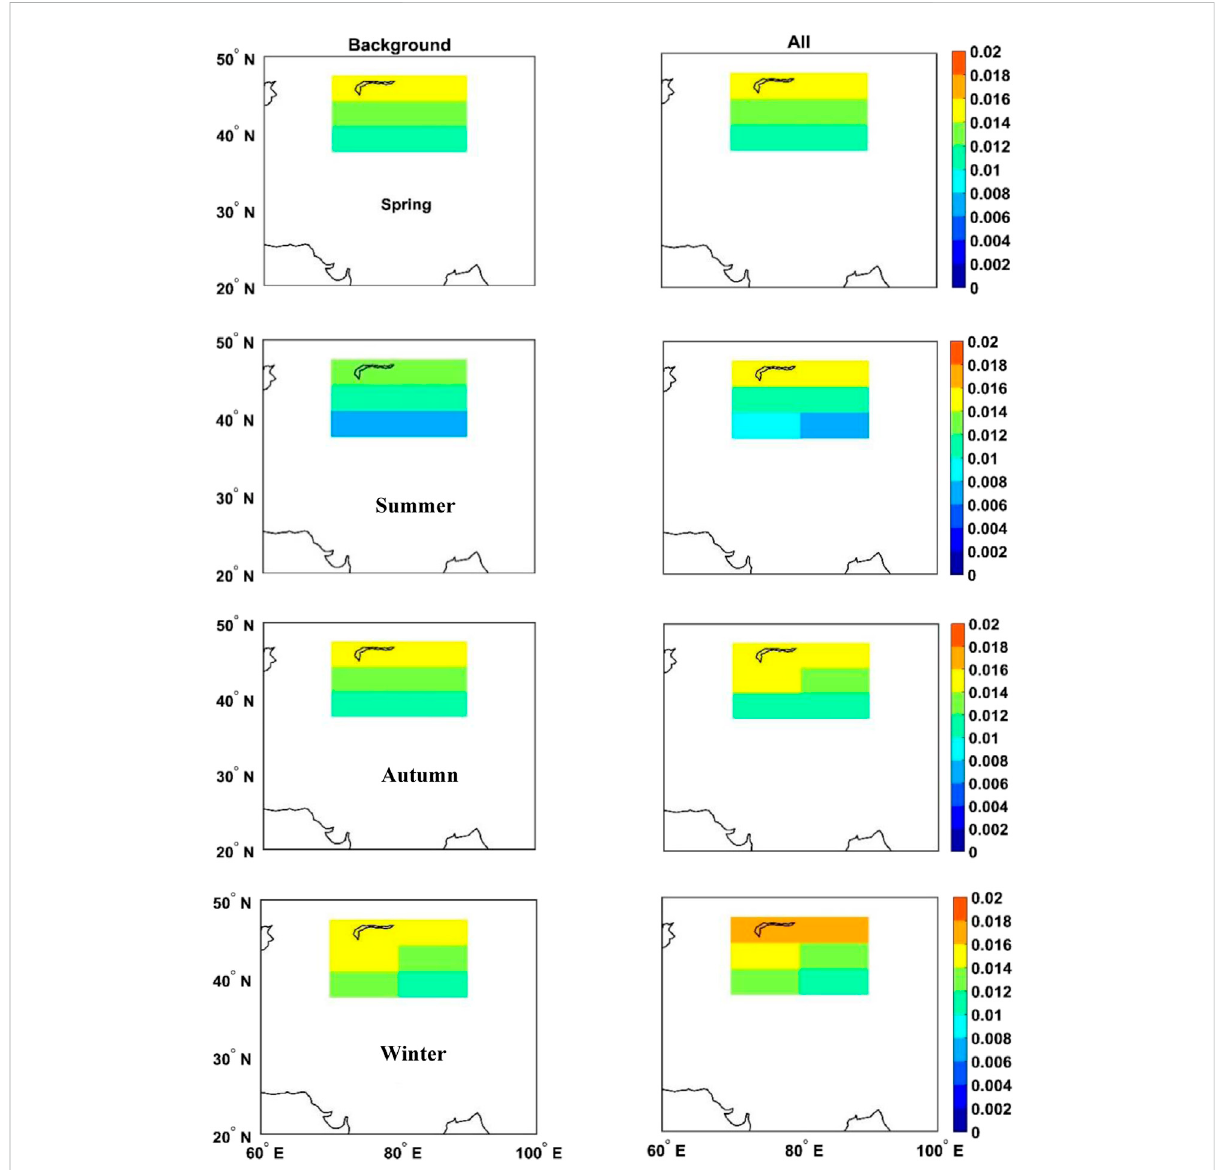
FIGURE 3 CALIPSO based distribution of mean background and total stratospheric A OD values over Xinjiang from 2007 to 2018 by